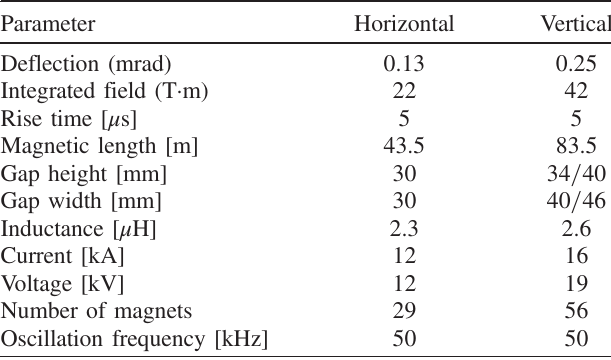
TABLE III. Dilution kicker magnet parameters [8,40], with a triplet. Parameter Horizontal Vertical Deflection